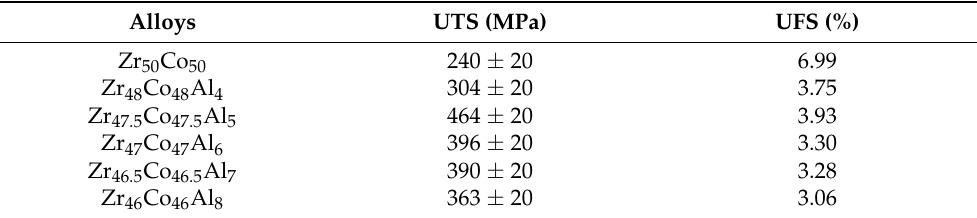
Table 1. Mechanical properties of Zr 50 − x/2 Co 50 − x/2 Al x (x = 0, 4, 5, 6, 7, 8) alloys including the ultimate